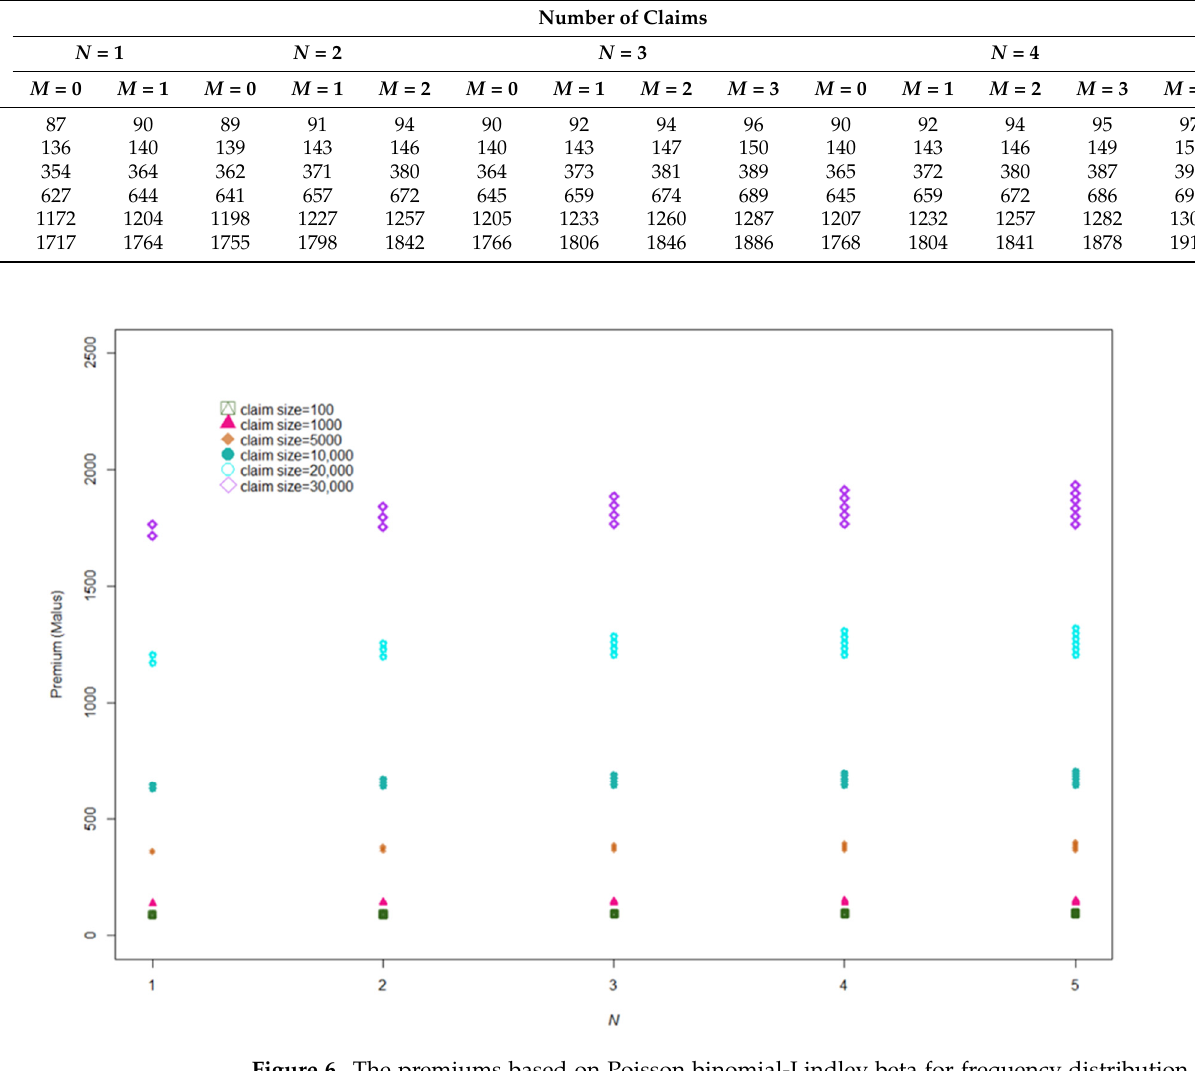
Figure 6. The premiums based on Poisson binomial-Lindley beta for frequency distribution and gamma-Lindley for severity distribution with various number of claims and claim sizes in the first year .